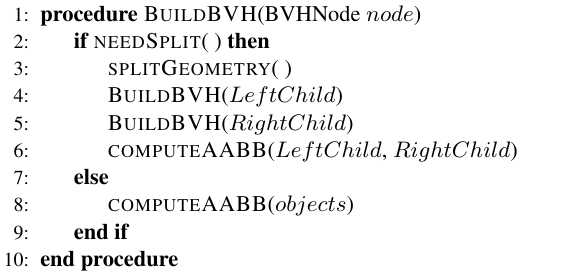
Algorithm 1 Recursive, Top-Down Construction of the